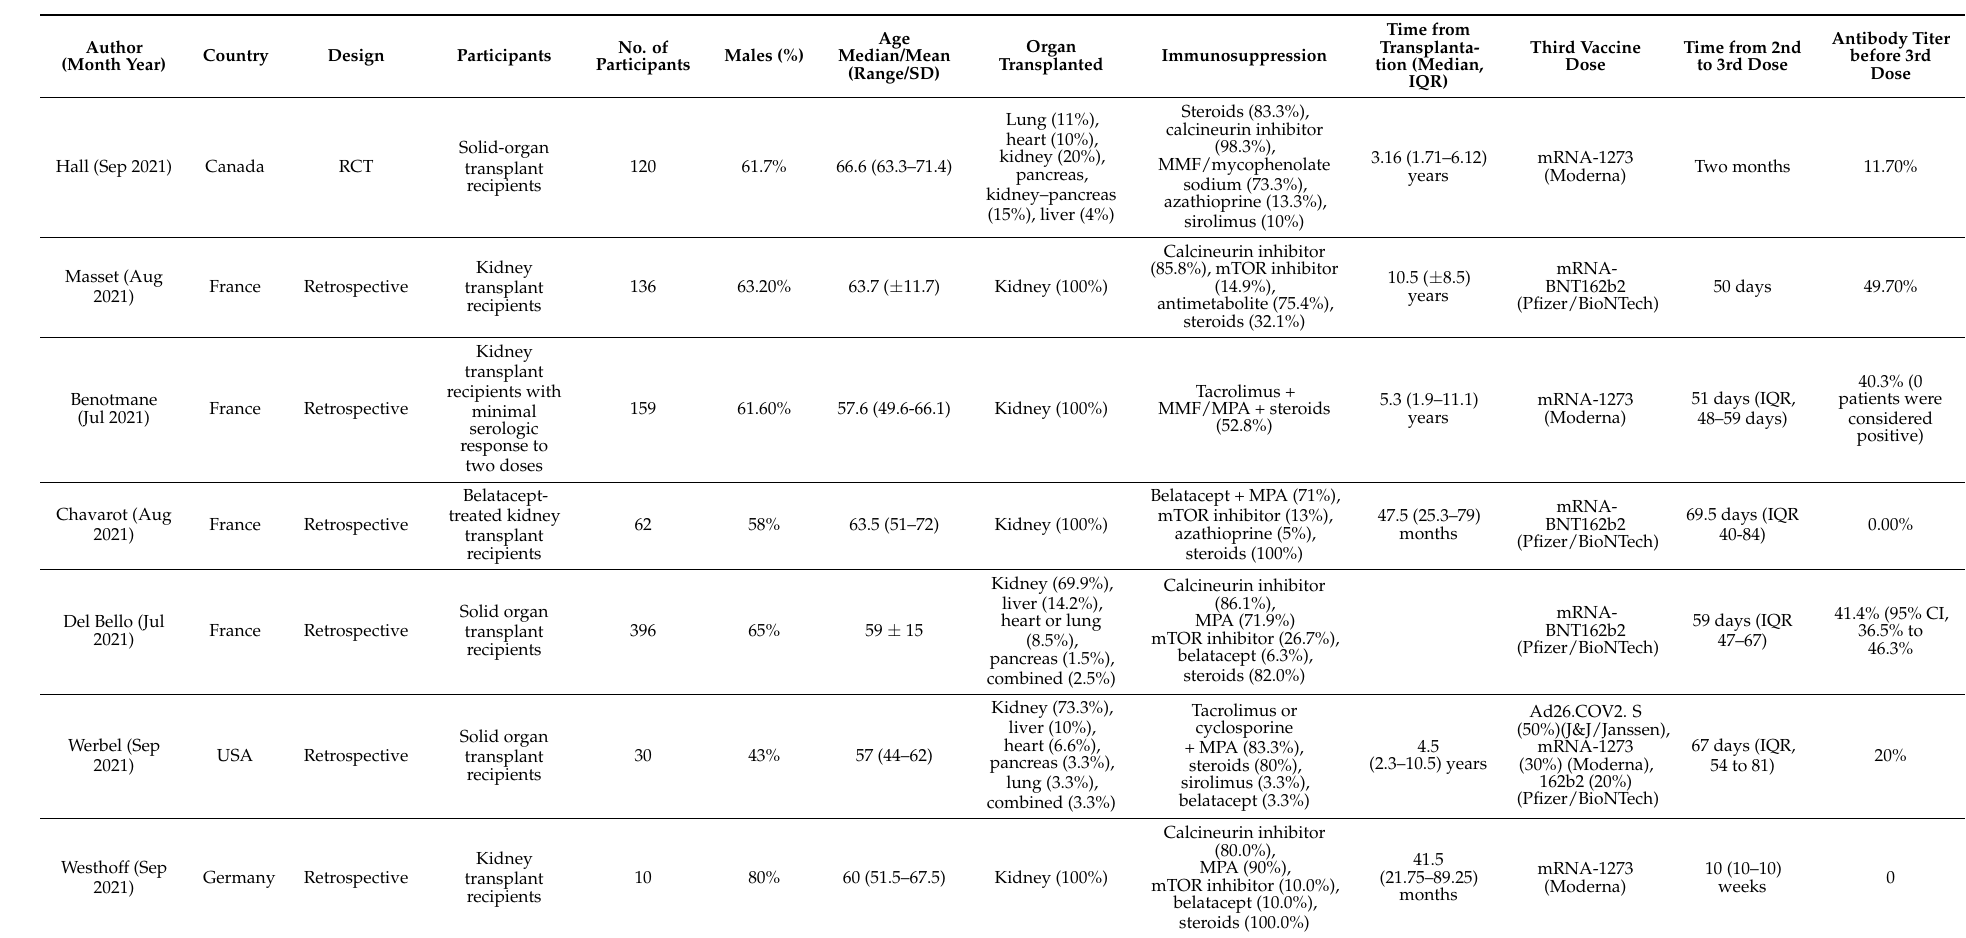
Table 1. Characteristics of included